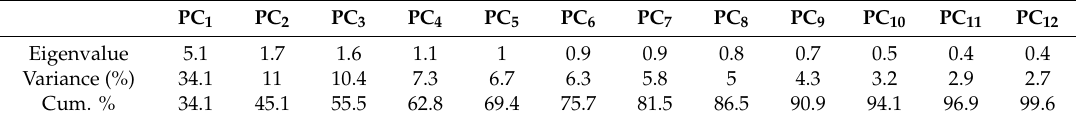
Table 2. Eigenvalues and percentage of explained variance by the first principal components. Only PC 1 to PC 6 are taken into account in this study.